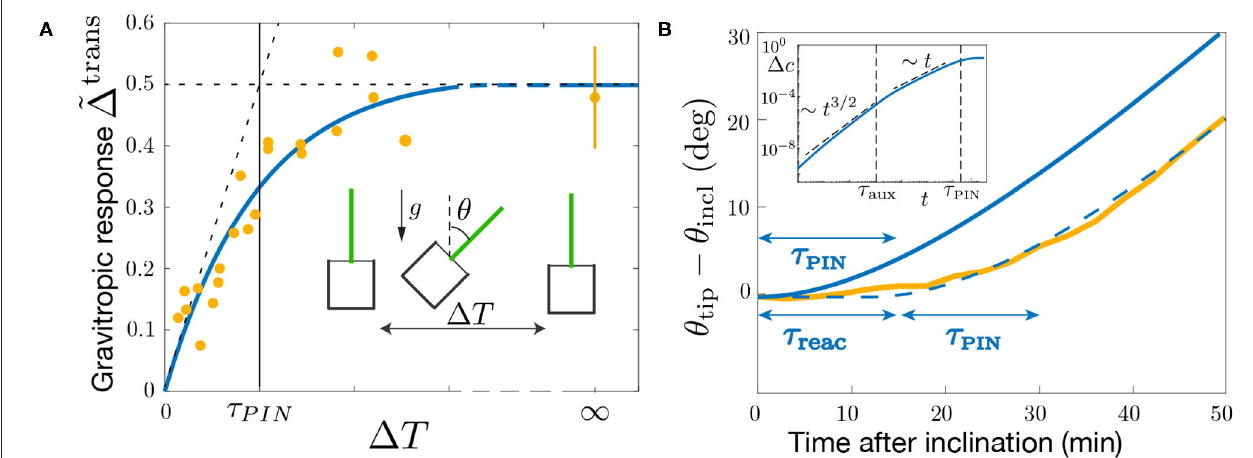
FIGURE 8 | Gravitropic response to a transient inclination (dose-response like protocol). (A) Maximal gravitropic response reached during the dynamics as function of the inclination time 1 T for θ 45 ◦ . The blue solid line is the model prediction using τ PIN 13 min ( τ aux /τ PIN 1 / 2,000 and τ 1 /τ PIN 0, other parameters are fixed as = = = = in Figure 7 ). Note that the curve is not sensitive to the exact value of τ aux /τ PIN and τ 1 /τ PIN as long as these values are small. Note also that the curve does not depend on P in the limiting pool regime P 1 considered. Symbols correspond to the results of Chauvet et al. (2019) obtained under normal Earth gravity (1 g ) and ≪ hypergravity condition (3 g ). (B) Evolution of the tip angle after an inclination θ 50 ◦ predicted by the model with the same parameters (blue solid line) and in the = experiments of Chauvet et al. (2016) (orange thick line). The predicted model must be shifted by a constant time τ reac 13 min to match the experimental curve = (dashed blue line). Inset: early time behavior of the gravitropic response predicted by the model in log-log